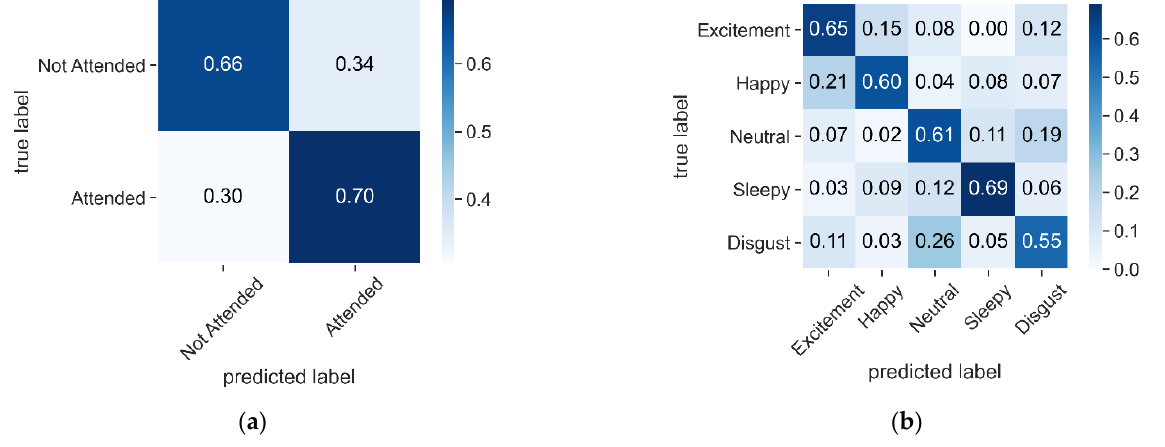
Figure 8. Confusion matrices for detection SVM models (10-fold cross-validation results): ( a ) attention classification model; ( b ) face emotion classification model.